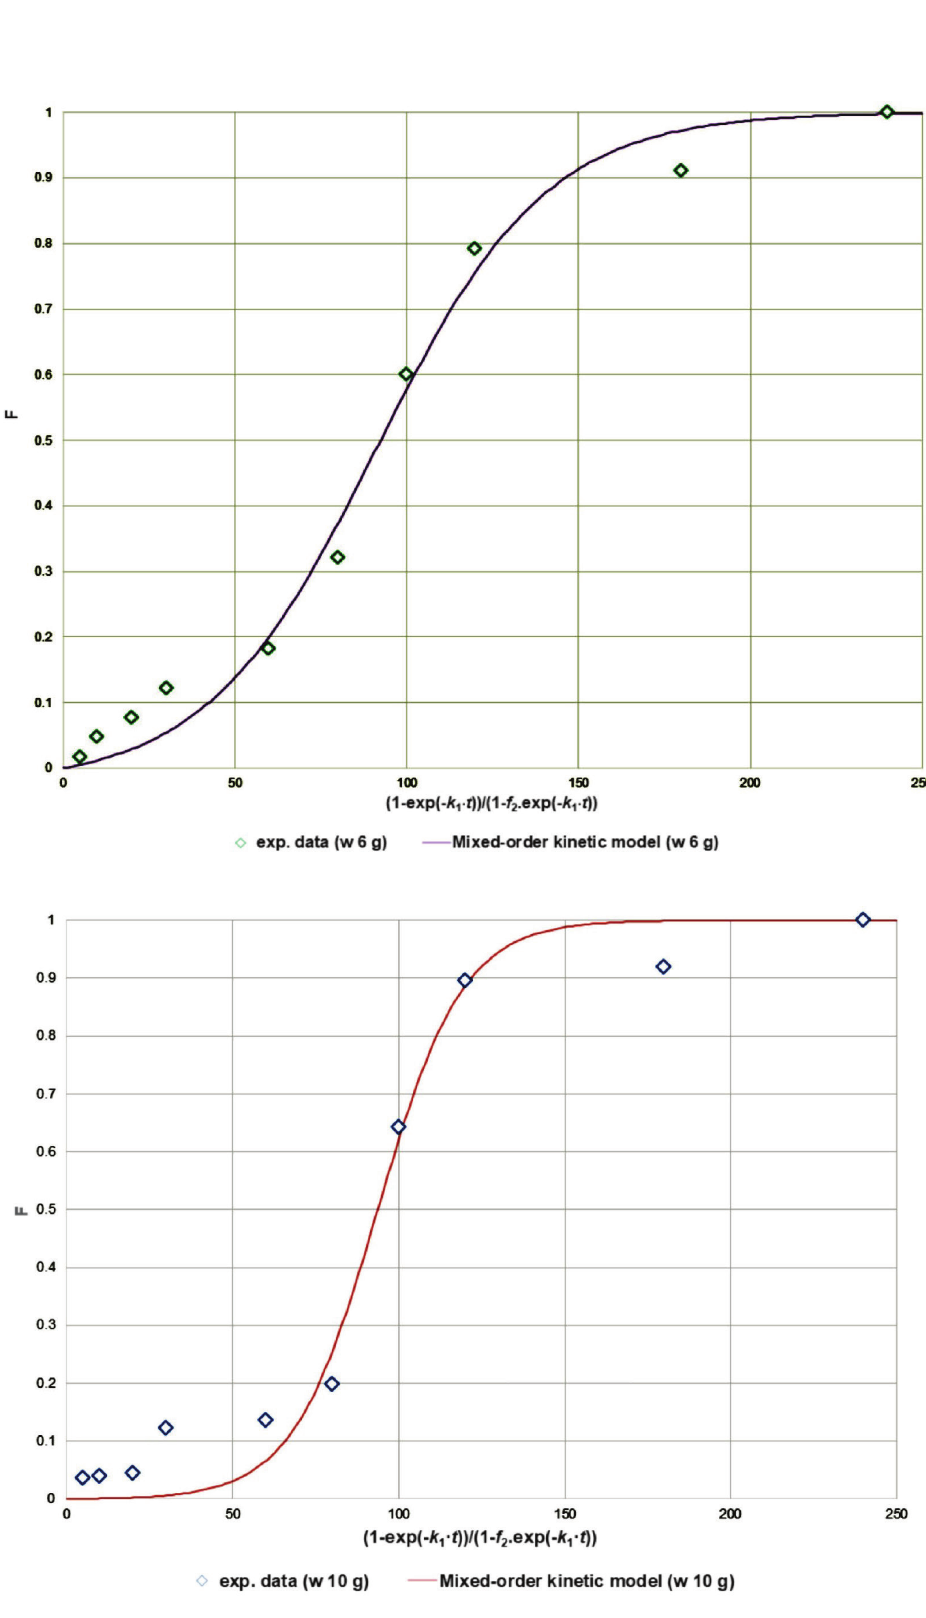
Fig. 5 – Experimental kinetics data and mixed-order kinetics